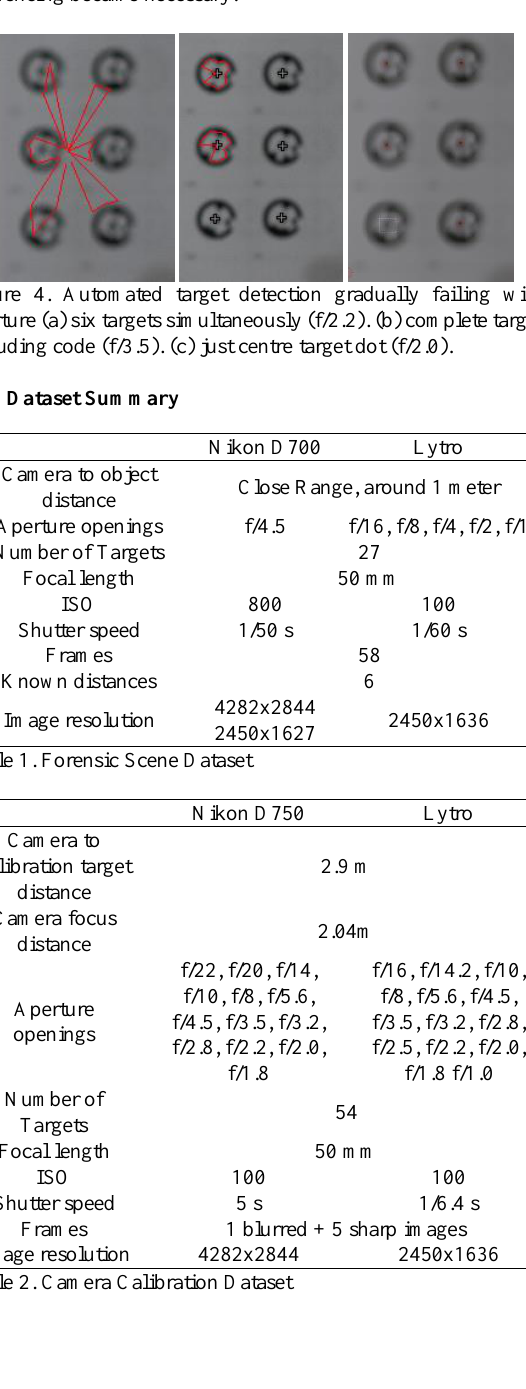
Figure 3. Image detail of DSLR camera calibration setup with part of the Siemens star at the top and a coded target in the bottom right. (a) sharp image (b) only dot targets are in focus, due to small depth of field.